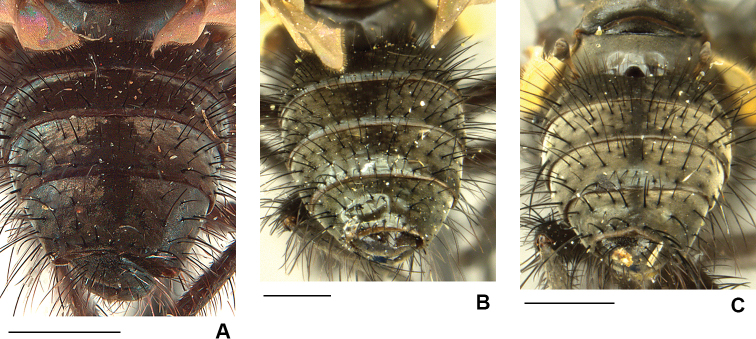
Male abdomen AD.
firthianaBD.
huckettiCD.
minor. Scale bars: 1 mm.